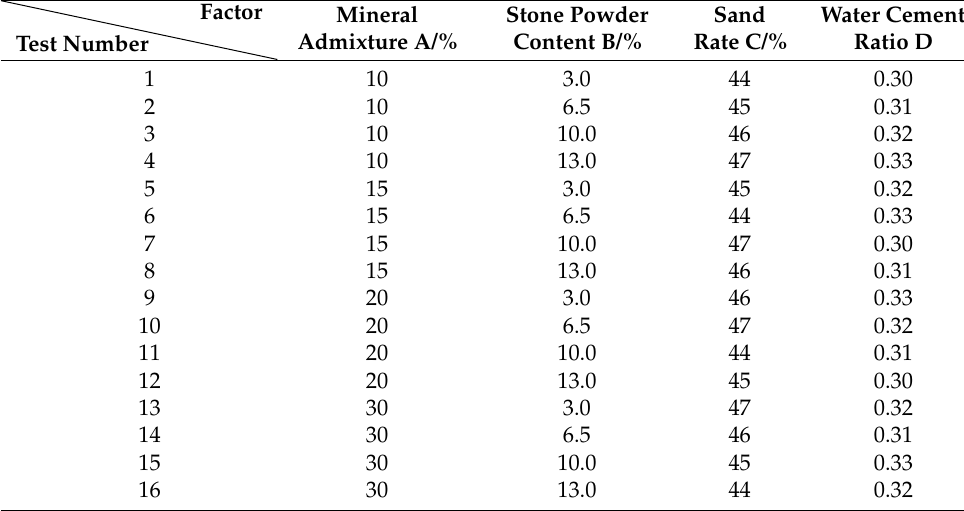
Table 3. L 16 (4 4 ) orthogonal experimental